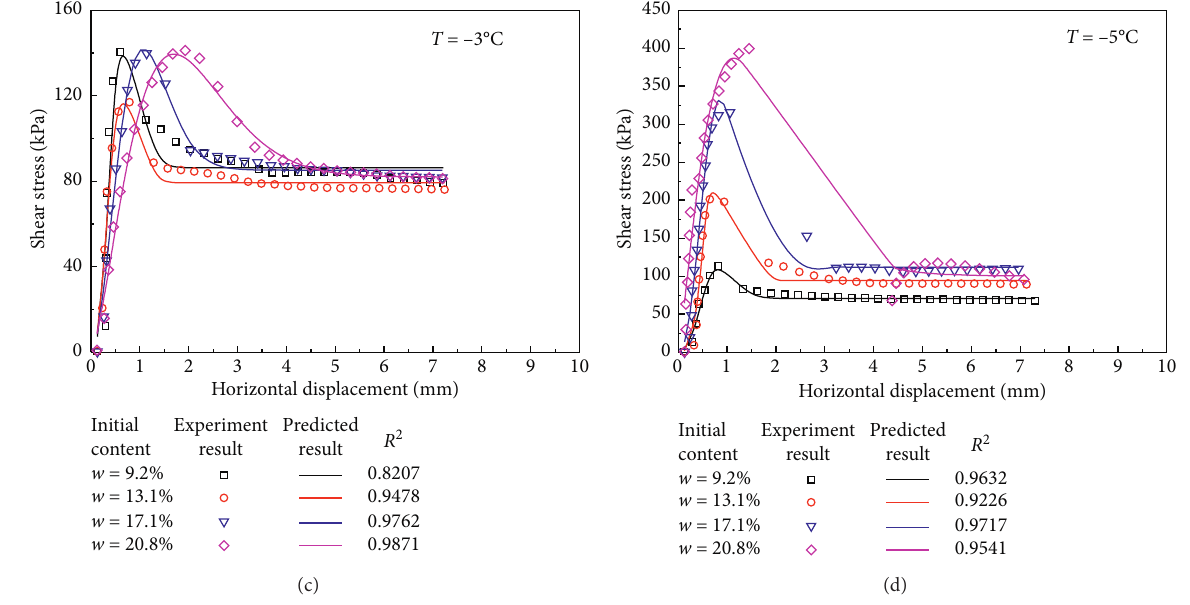
Figure 8: Experimental and predicted interface